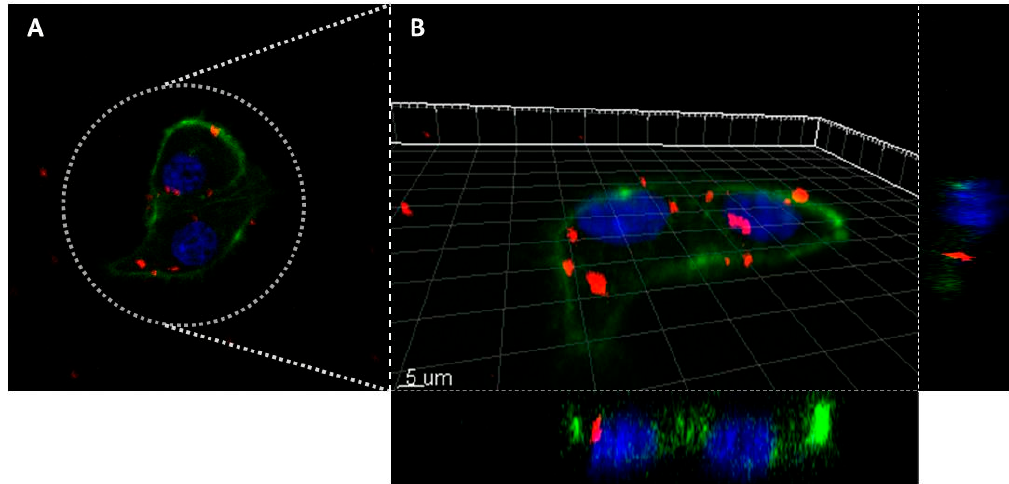
Figure 8. Confocal laser scanning microscope images of the MDA-MB-231 cells incubated overnight with the nanomaterial AX-3 ( A ): 2D image; ( B ): 3D reconstruction). Colors legend: MSN nanoparticles are in red (Alexa Fluor 647, Ex.650 / Em.665 nm), cellular nucleus are in blue (DAPI staining, Ex.358 / Em.461) and actin filaments are in green (Phalloidin staining, Ex.495 / Em.519